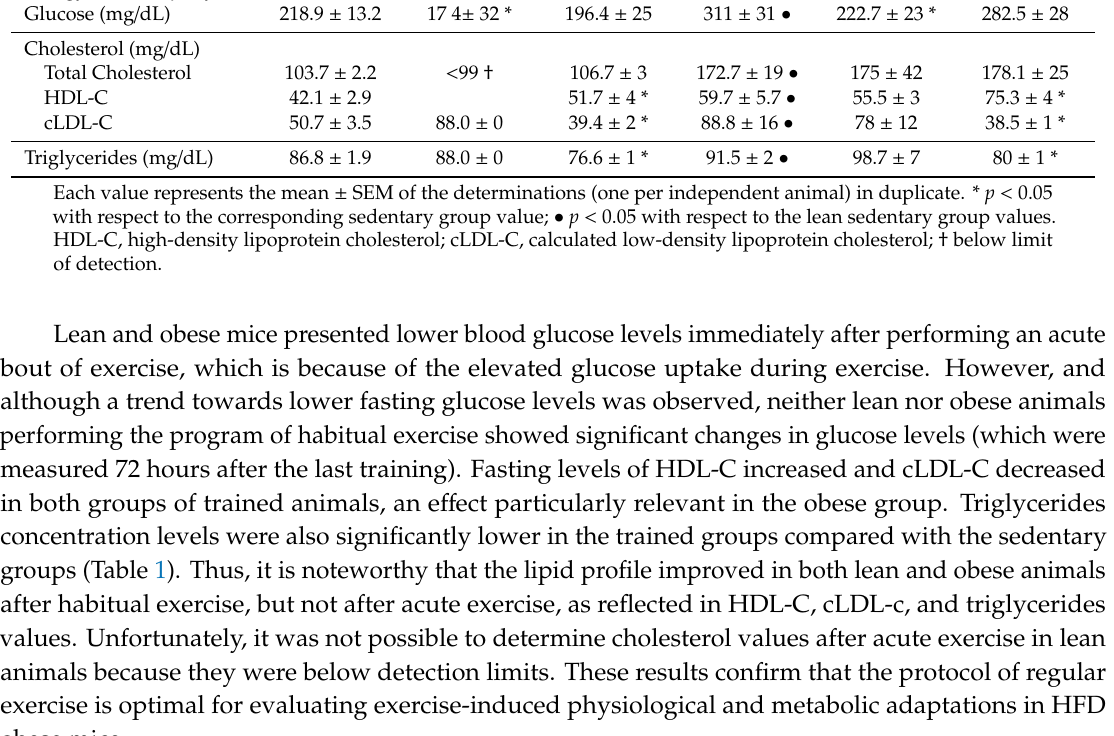
Table 1. Body weight, dietary intake, and fasting blood glucose and lipid profile in lean and obese mice, without (sedentary) and with exercise, both acute and habitual (trained). Lean Obese Acute Acute Trained Trained Sedentary Sedentary Exercise Exercise Body Weight (g) 29.3 ±